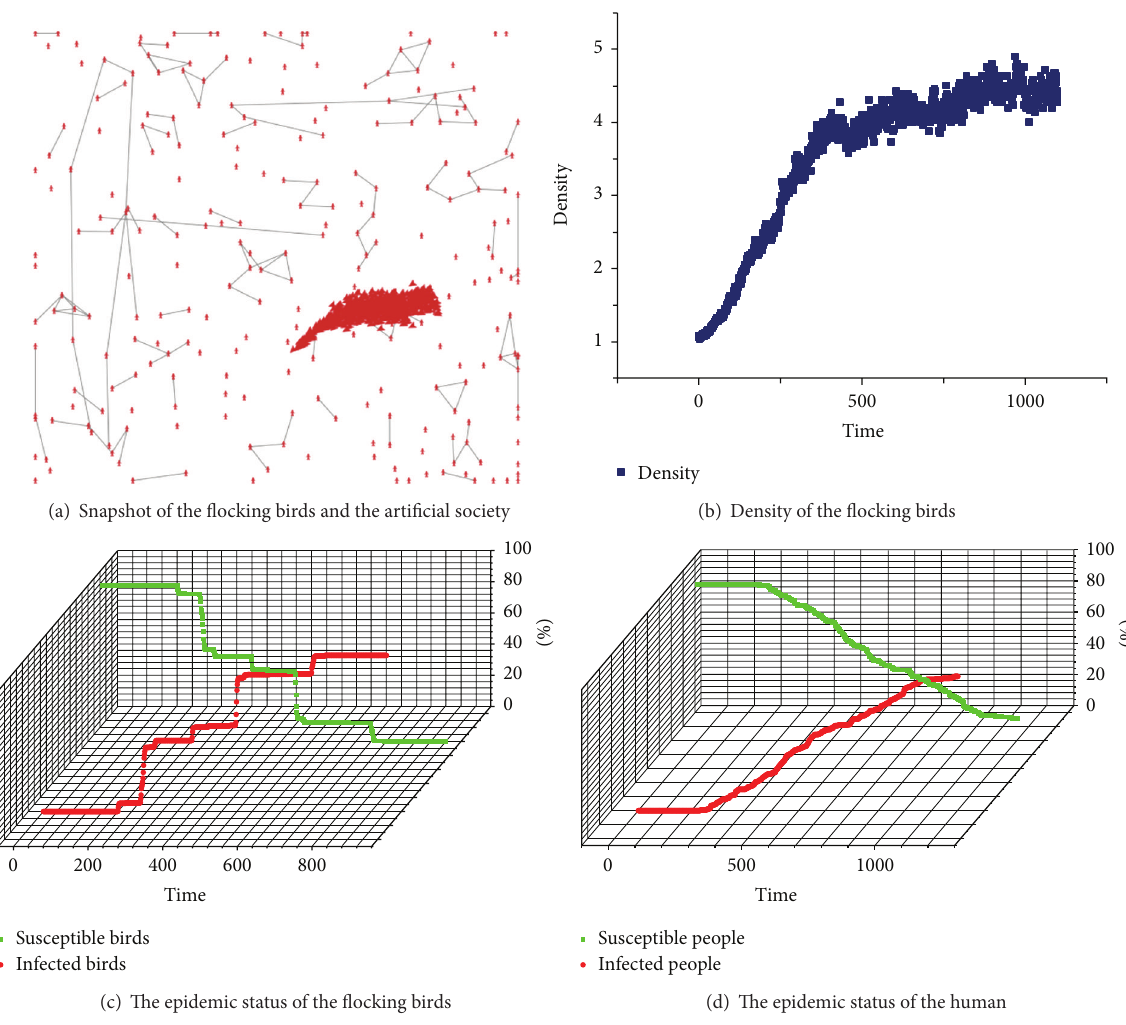
Figure 9: The simulation results with the parameter min separation =